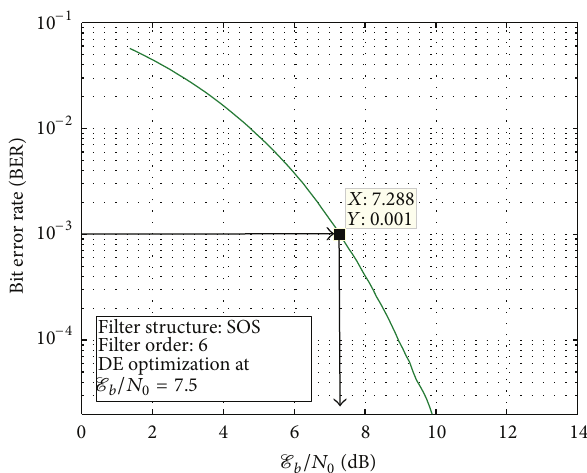
Figure 6: Transceiver BER for the optimum solution found by the DE algorithm. The operating point for fixed- and floating-point analysis is chosen to be at a BER of 10 −3 resulting in an E 𝑏 /𝑁 0 ratio of 7.288